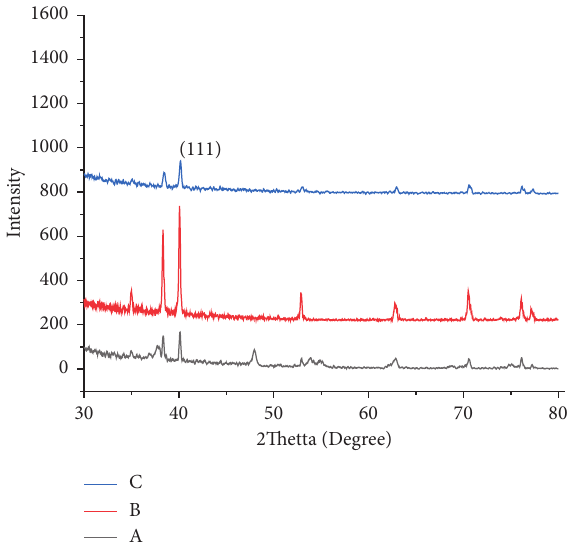
Figure 1: XRD plots of lead selenide films deposited at various bath temperatures: (a) 20 ° C. (b) 45 ° C. (c) 85 ° C. Table 1: Comparison of evaluated and standard “ d ” and 2 θ values for nano-synthesized PbSe thin films with varying bath tempera- tures (20 ° C, 45 ° C, and 85 ° C) and deposition time of 95min. Sample Temperature ( ° C) 2 θ (radians) FWMH ( ° )